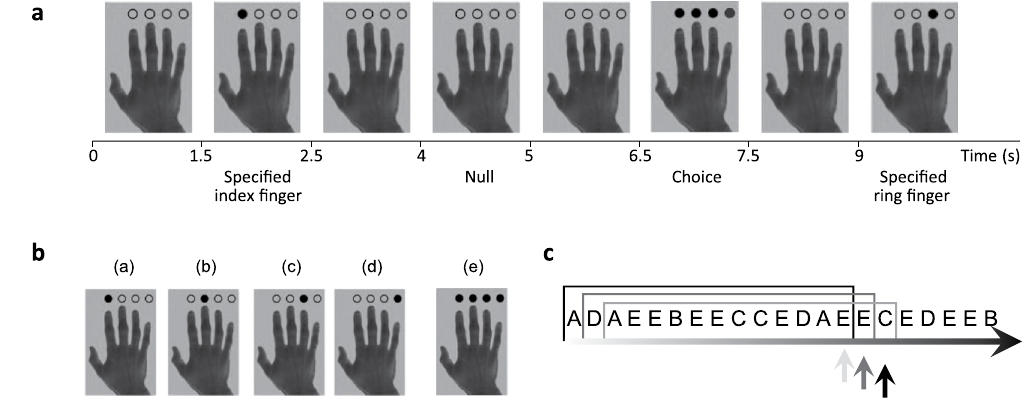
Figure 1. The four-choice action selection experiment design. ( a ) An example trial sequence with specified (one circle filled), choice (four circles filled) and null trials (no circles filled). The image of the hand with unfilled circles remains on screen between trials for 1.5 seconds. Each stimulus trial is presented for 1 second, with 2.5 second stimulus onset asynchrony. ( b ) The experimental stimuli used in the action selection task. Trials (a–d) are the specified trial cues where the participant was cued to press the specified finger. Trial (e) is the choice trial cue where the participant was cued to make an action with a finger of their choice. ( c ) We show an example of a trial window incrementally sliding over trial stimuli (a–e in B) to calculate the entropy of stimuli or actions preceding the current trial. The trial entropy (TE) and selection entropy (SE) values were assigned to the last trial within the window as the arrows show. Figure adapted with permission from 11